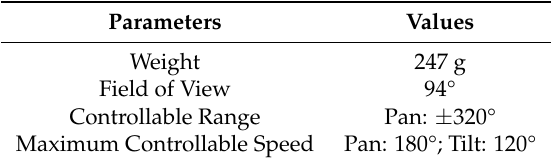
Table 2. Technical specifications of DJI Zenmuse-X3 gimbal camera.